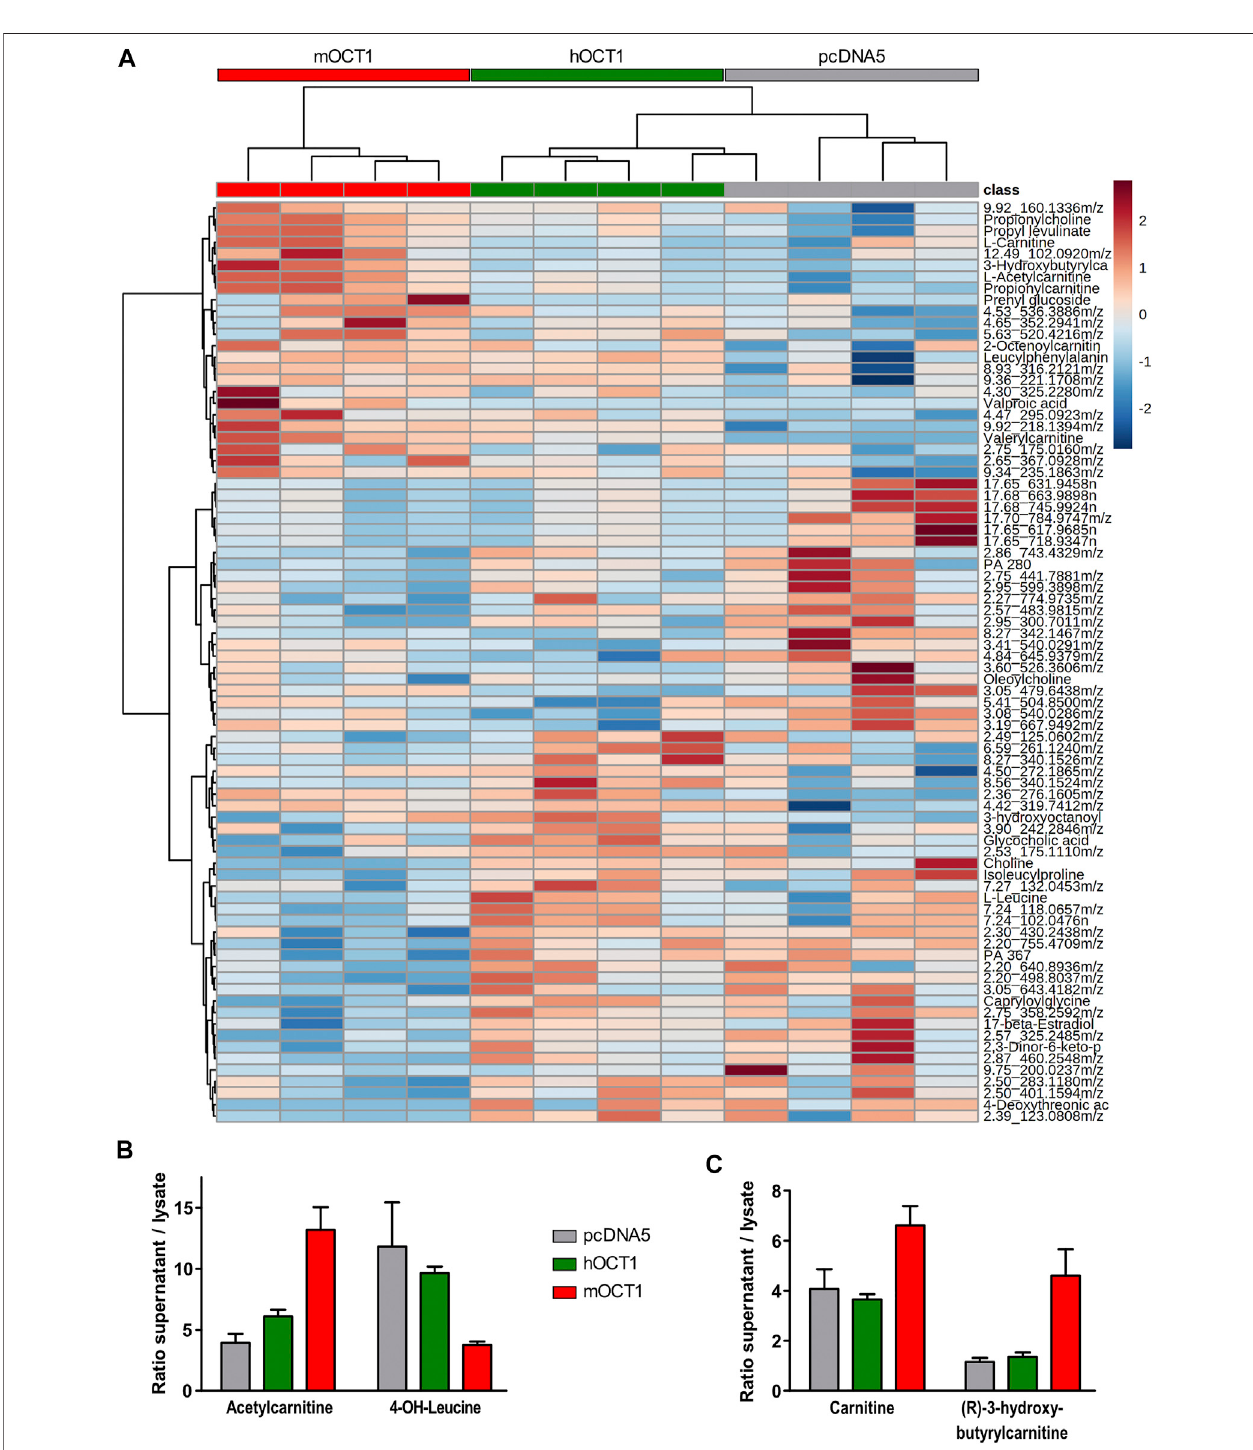
FIGURE 6 | Metabolomic analyses from hOCT1 or mOCT1 overexpressing HEK293 cells (A) Hydrophilic interaction chromatography coupled with positive ionization mode mass spectrometry led to identi fi cation of metabolites differentially taken up from human normal donor blood plasma. If substances could not unambiguouslybe identi fi ed based ontheir masses,the retention times and themass-to-chargeratios areprovided.Datafor heatmap wasnormalized and clusteringof the 80features with lowestANOVA p -value isshown.Euclidean distance and Ward-clusteringwereused.Asindicatedbythe red,green and gray bar showing the mOCT1, hOCT1 and empty vector transfected cell lines, with one exception clustering re fl ected the different effectsof mOCT1 and hOCT1 very well (B) Identi fi cation by retention time and mass revealed varying uptake byhOCT1 and mOCT1. Mean ± SEM, n (cid:2) 4 (C) Differences were also observed for substances identi fi ed only by mass database. Data are represented as the mean ± SEM from four independent